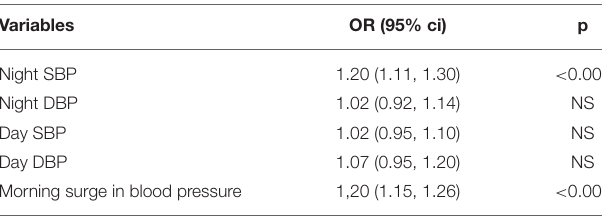
TABLE 3 | Binary logistic regression analysis for factors associated with morning hypertension.